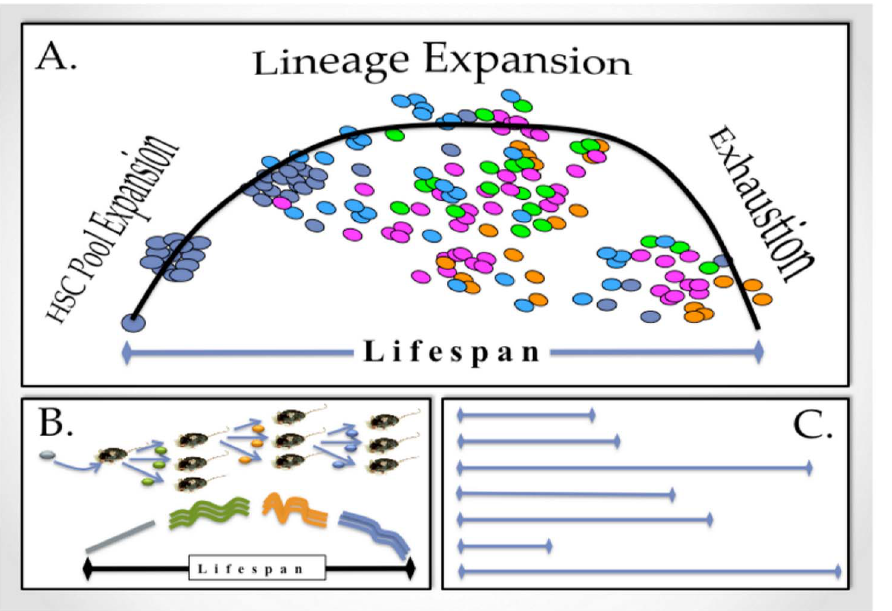
Figure 2. The Life of A Hematopoietic Stem Cell. A: Limited lifespan: When a monoclonal hematopoietic system is initiated by transplanting a single HSC (dark blue sphere), it expands to a pool of clonal HSCs through self-renewal (cluster of blue spheres). This pool distributes through the organism. HSCs differentiate to generate mature cells of all lineages (shown as magenta, orange, green, light-blue spheres). This process depends on the intrinsic properties of the founder HSC [63,65]. The overall output of mature cells in blood (measured in %-donor type cells; vertical axis (not shown in the figure)) over time (horizontal axis labelled ‘‘Lifespan’’) is indicated by the black curve. For all normal HSCs, this kinetic has a ballistic shape, thus indicating that a clone’s ability to produce mature cells of all major lineages (the lifespan) is limited. The lifespan is mathematically predictable with high accuracy from few initial points of the repopulation kinetic [8]. B: Programmed Lifespan: When daughter HSCs derived from a single ancestral HSC are transplanted into separate hosts, the repopulation kinetics are very similar (modified from [2]). In particular, all daughter HSCs become extinct at the same time [8]. This suggested that the lifespan is epigenetically fixed (programmed) and heritable in self-renewal. C: Lifespan Diversity: The relialogram illustrates that when HSCs are sampled from bone marrow, lifespans of different durations are found [2,66,67]. Therefore, the length of time for which HSCs can repopulate an ablated host varies according to the epigenetic programs of individual HSCs.